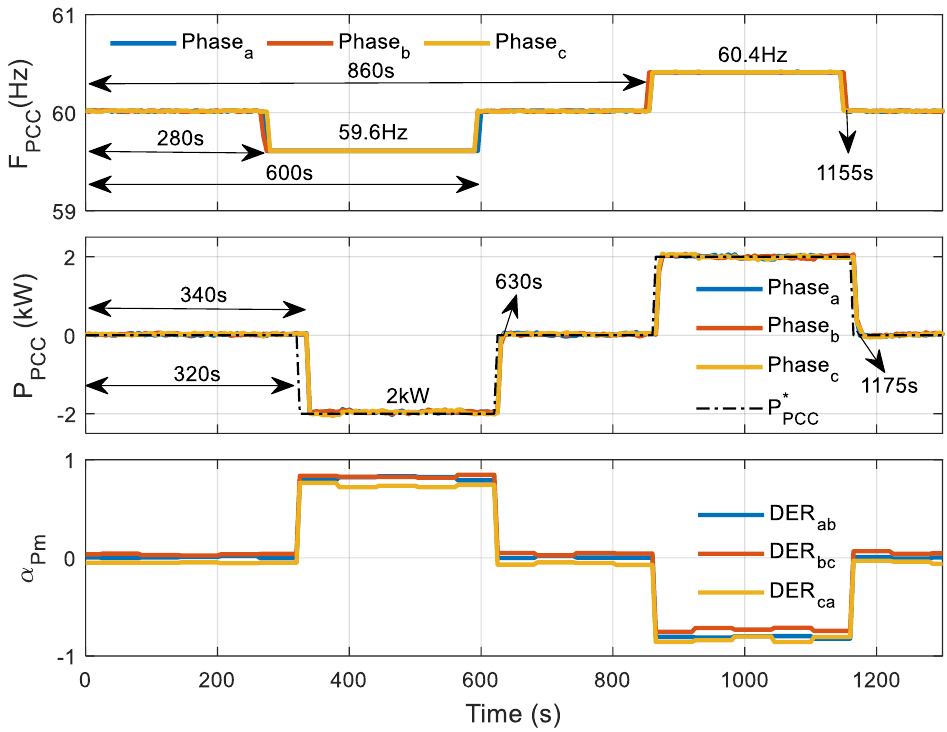
Figure 10. Line frequency, PCC active power and coefficients α P frequency variation.